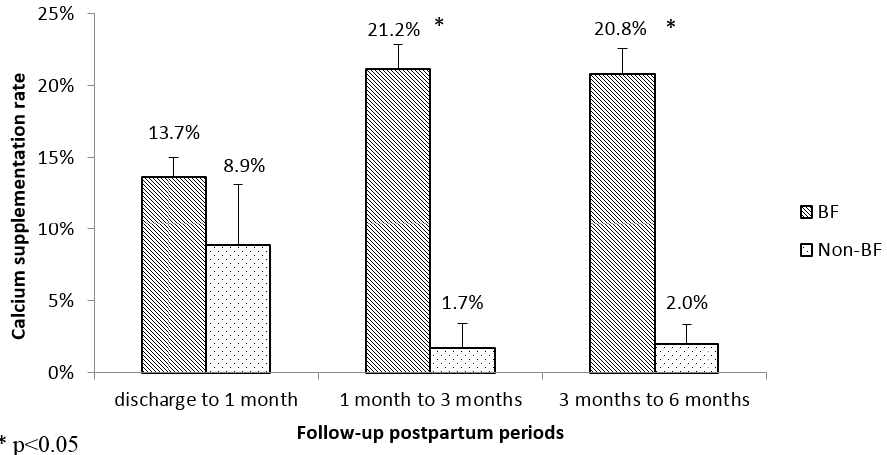
Figure 1. Calcium supplementation postpartum in Jiangyou.